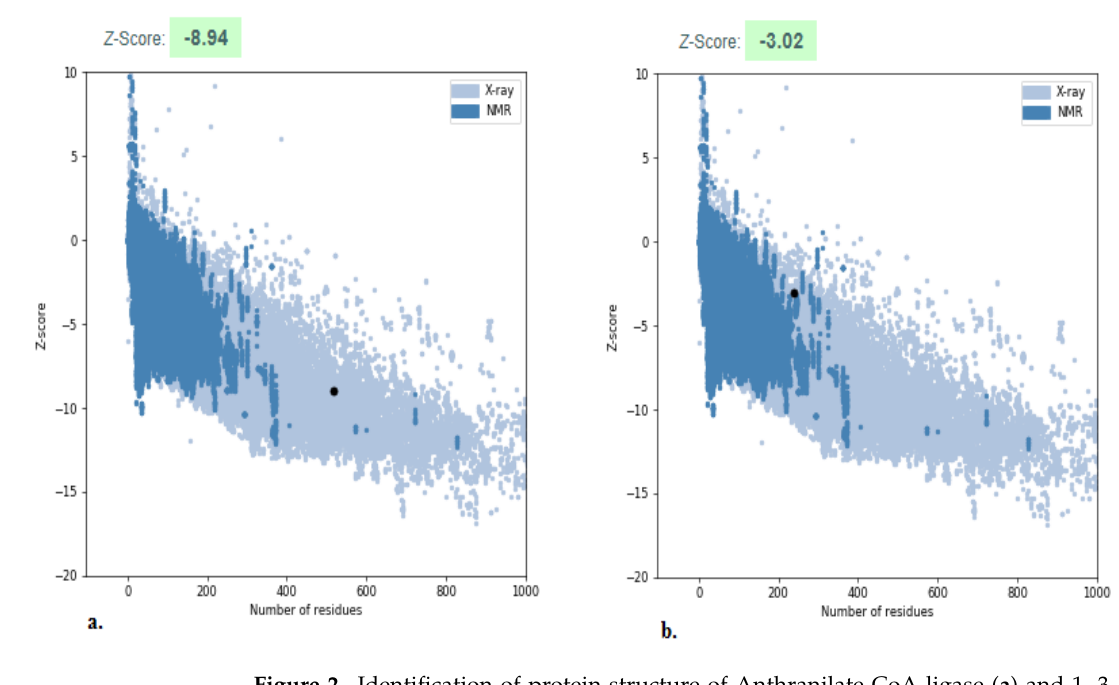
Figure 2. Identification of protein structure of Anthranilate-CoA ligase ( a ) and 1, 3- β –D-glucan synthase ( b ) using ProSA.